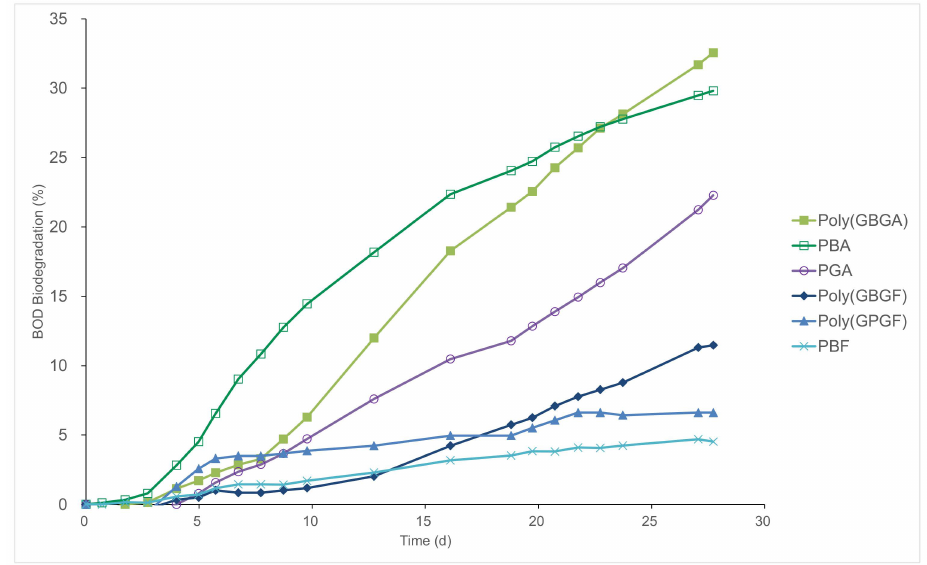
Figure 4. Biodegradation (BOD) of the homo- and copolyesters in seawater at 27 ◦ C. The poly(GBGF) and poly(GPGF) samples exhibited 11.5% and 6.5%